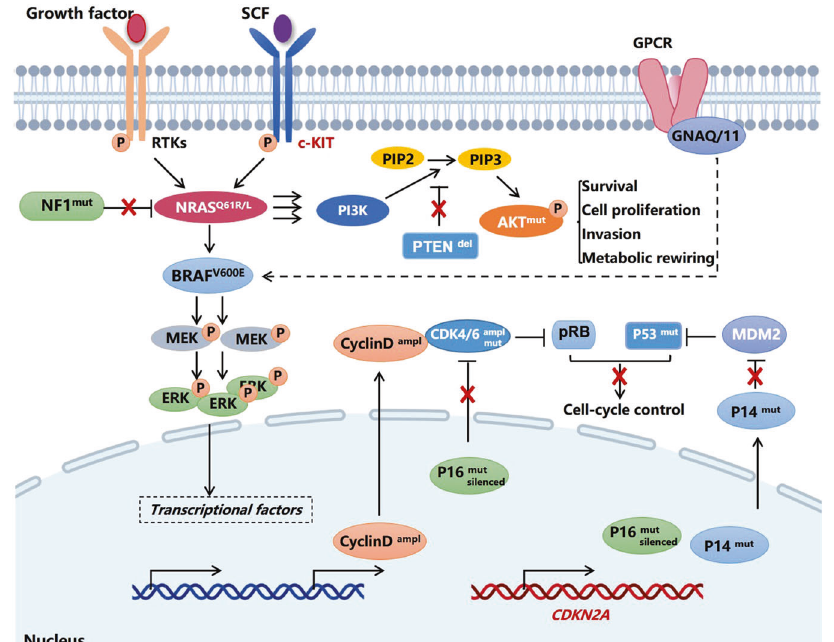
Fig. 3 Mutated driver genes and downstream signal pathways in melanoma. Ampl ampli fi cation, CDK cyclin-dependent kinase, Del deletion, GPCR G protein-coupled receptor, Mut mutation, P (in a pink circle) phosphate, p14 ARF and p16 INK4A splice variant encoded by CDKN2A gene, PIP2 phosphatidylinositol-(4,5)-bisphosphate, PIP3 phosphatidylinositol-(3,4,5)-trisphosphate, PTEN phosphatidylinositol ‑ 3,4,5 ‑ trisphosphate 3 ‑ phosphatase, and dual-speci fi city protein phosphatase, RB retinoblastoma-associated protein, RTK receptor tyrosine kinase, SCF stem cell